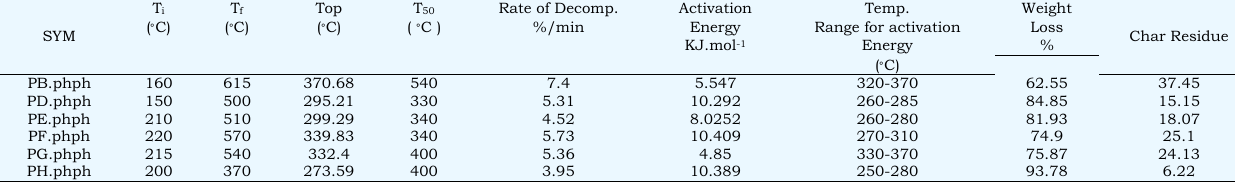
Table 3 Values obtained from Tga curves for some prepared polymers